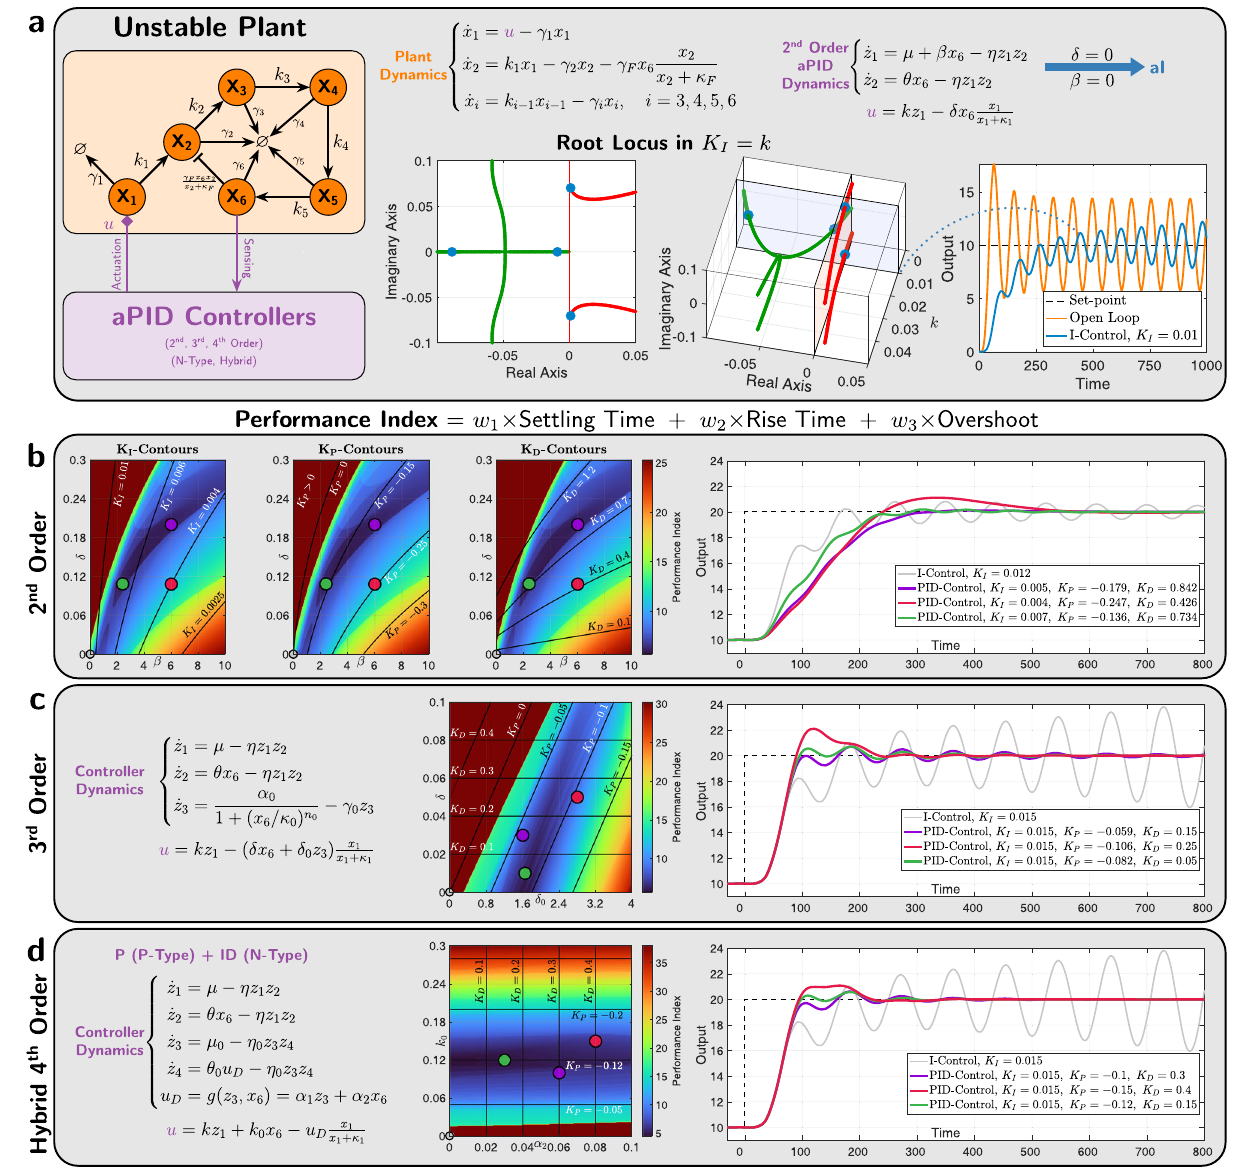
Fig. 7 a PID control of an unstable and more complex plant. a Plant description. The plant considered here involves L = 6 species and embeds a negative feedback from the output Z 6 to X 2 via an active degradation reaction. The underlying deterministic dynamics of the plant and the second-order a PID controller are shown in this panel. It is demonstrated that the open loop is unstable (orange response), and integral control alone cannot stabilize the dynamics since two eigenvalues carry on a positive real part for any k ≥ 0. b – d Performance of the various a PID controllers. The intensity plots show the performance index over a range of biomolecular parameter values. These plots are overlaid with contours where the PID gains K P , K I or K D are constant. For the third and fourth-order a PID in ( c ) and ( d ), K I ≈ k and thus can be tuned separately with k that is held constant throughout this fi gure. For the fourth- order a PID in ( d ), the K P - and K D -contours are orthogonal to the k 0 - and α 2 -axes, respectively, and hence can also be tuned separately. For the third-order a PID in ( c ), the K D -contours are orthogonal to the δ -axis and hence K P can be tuned separately with δ 0 , whereas the inseparability of the PD components forces the K P -contours to be oblique, and thus δ tunes both K P and K D simultaneously. Finally, for the second-order a PID in ( b ), all three contours are not orthogonal to the axes and, as a result, all three PID gains have to be mutually tuned by the biomolecular parameters. This is due to the inseparability of all PID components. Note that each set of contours is displayed on a separate intensity plot here for clarity. Observe that the optimal performance for each controller is located in the dark blue regions where the proportional gains K P are negative. Three different examples, red, green, and purple (along with the unstable standalone a I control in gray), are picked to demonstrate the achievable high performances depicted in the response plots to the right. For the second and third-order a PID, negative K P can be achieved by properly tuning the biomolecular parameters without having to switch the topology from N-type to P-type. However, for the (separable) fourth-order a PID controller, a hybrid design with N-type ID and P-type P can also achieve a negative K P that is critical for controlling this